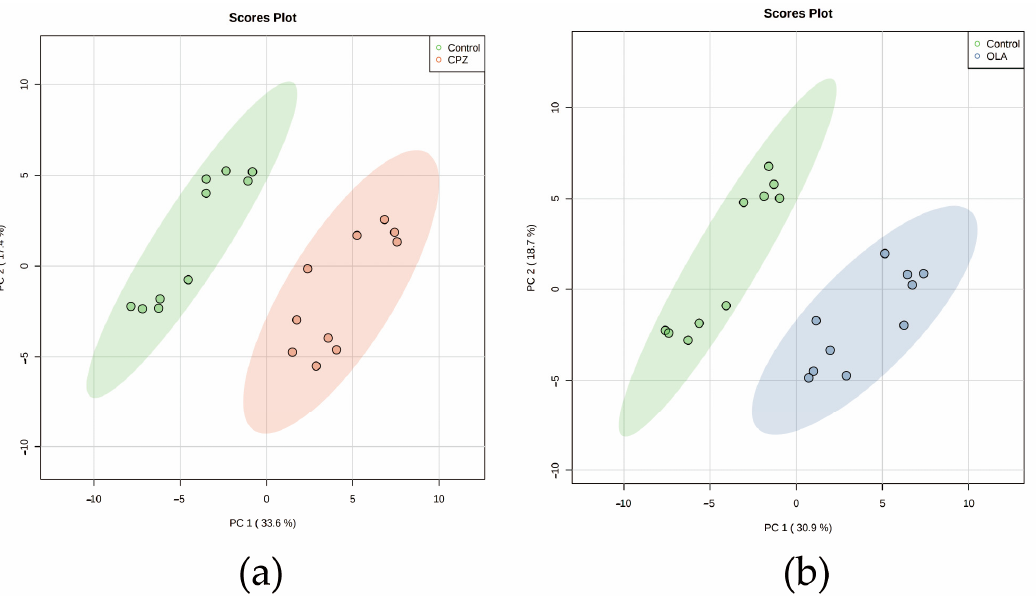
Figure 1. Plots of PCA score for metabolic profiling of the fatal-intoxication animal model. ( a ) CPZ and ( b ) OLA fatal intoxication vs. controls. n = 10. Abbreviations: CPZ: fatal intoxication by CPZ at a high dose; OLA: fatal intoxication by OLA at a high dose. Table 2. Differential metabolites after fatal intoxication by CPZ.